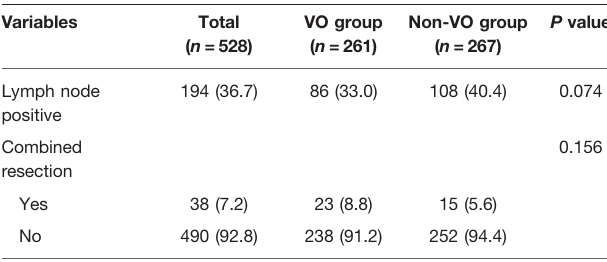
TABLE 1 | Comparison of clinical characteristics between the VO group and the Non-VO